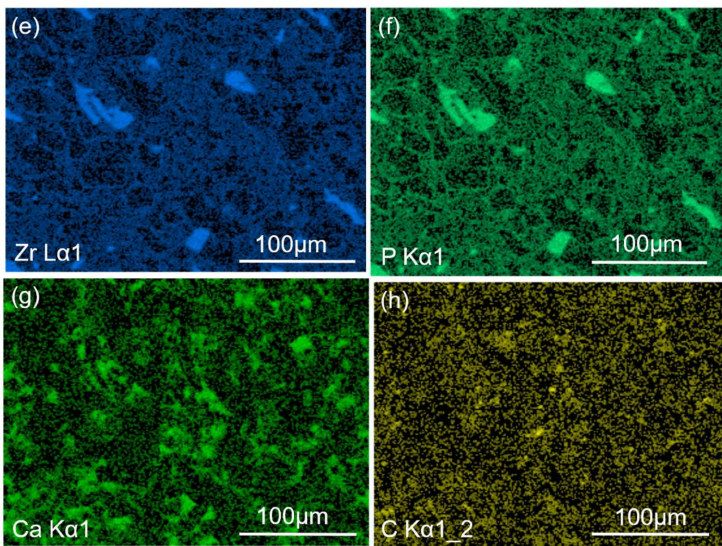
Figure 6. ( a ) SEM micrographs of the 0.5-GNFs nanocomposite sintered at 1000 ◦ C. The corresponding mapping scanning results of elements: ( b ) Ti; ( c ) Ta; ( d ) Nb; ( e ) Zr; ( f ) P; ( g ) Ca; and ( h )